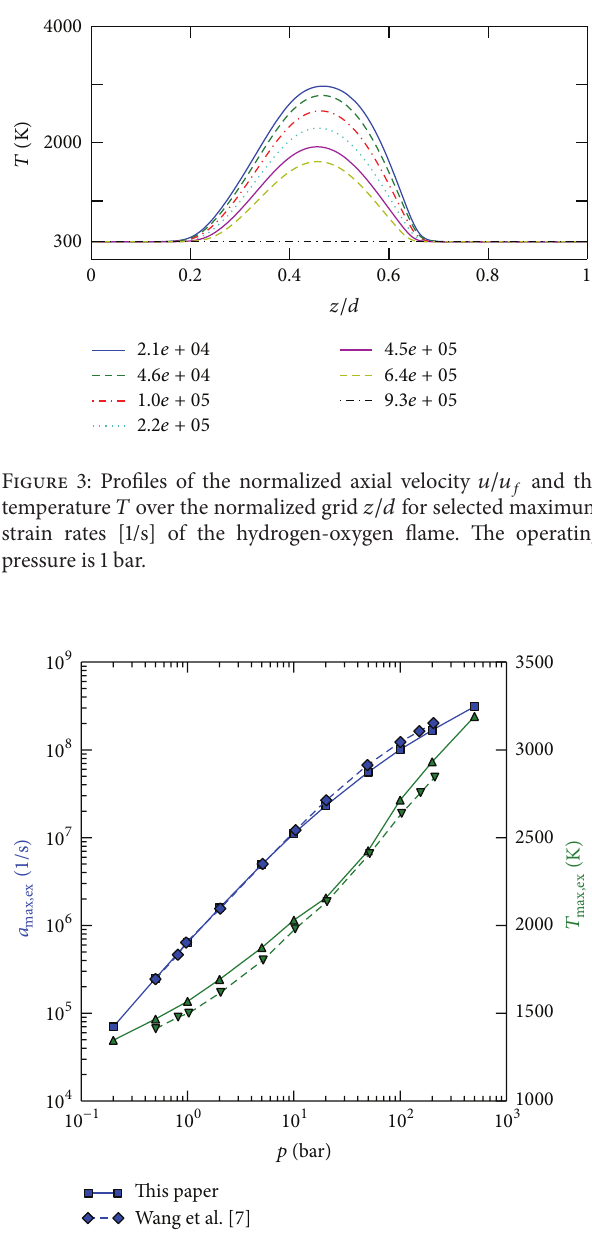
Figure 4: Maximum strain rates and maximum temperatures for H 2 -O 2 counterflow flames just before the extinction point as a function of pressure. The reference data is taken from Wang et al.